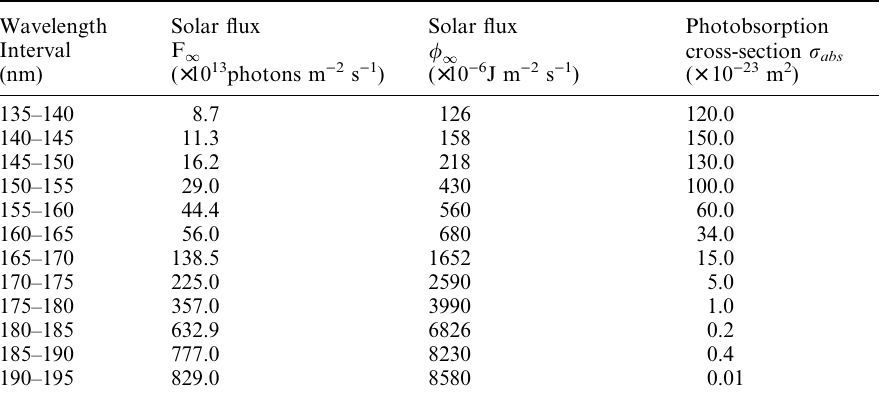
Table 1. Unattenuated solar flux intensities and photoabsorption cross-sections for wavelengths 135–195 nm. Solar flux intensities are taken from Heroux and Hinteregger (1978) and correspond to an F10.7 of 70. For wavelengths (cid:107) < 175 nm photoabsorption cross-sections are taken from Torr et al . (1980b); all other cross-sections are taken from Watanabe (1958) Wavelength Solar flux Solar flux Photobsorption